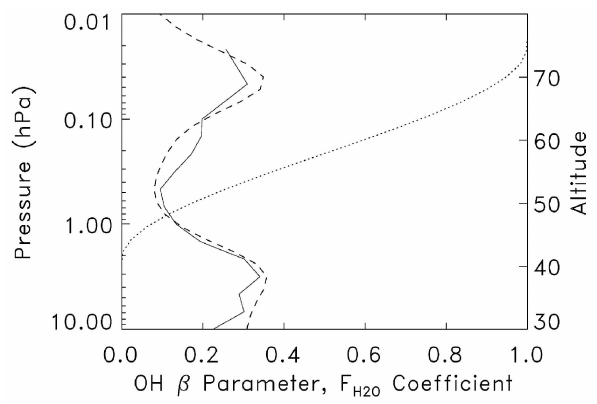
Fig. 7. Mean β from 2004–2008 MLS OH measurements (solid), along with the best-fit β profile using a linear combination of ozone and water vapor photodissociation raised to the power of 0.45 (dashed). The dotted curve shows the implied relative contribution of water vapor photodissociation to the total production of HO x ( F H2O , as described in the text).